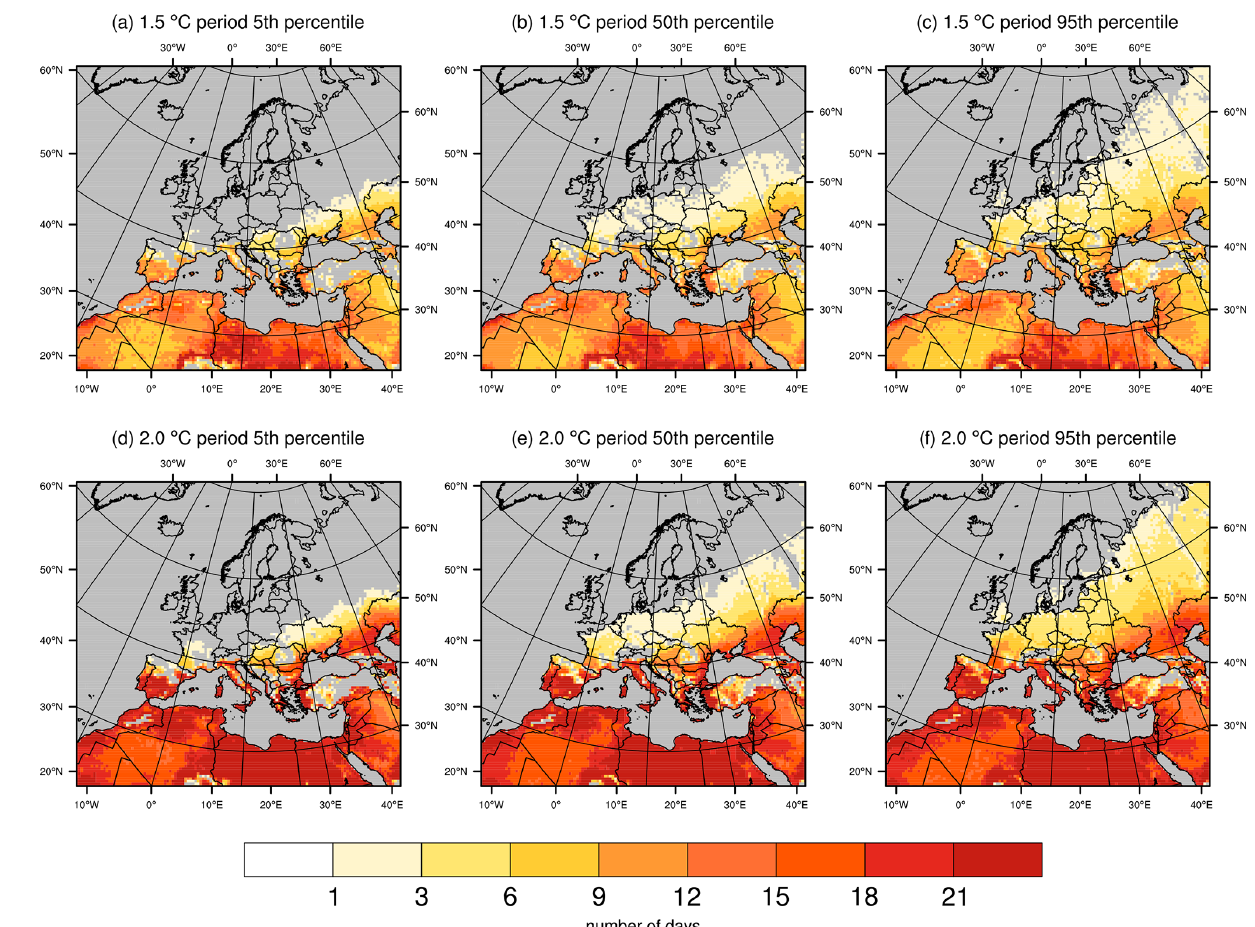
Figure 3. Same as Fig. 2, but for the ECHAM6-driven REMO